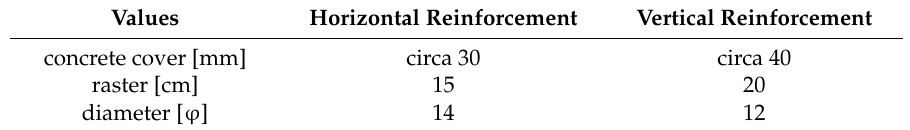
Table 13. Properties of reinforcement in bridge wings, grasped from design documents and performed tests.